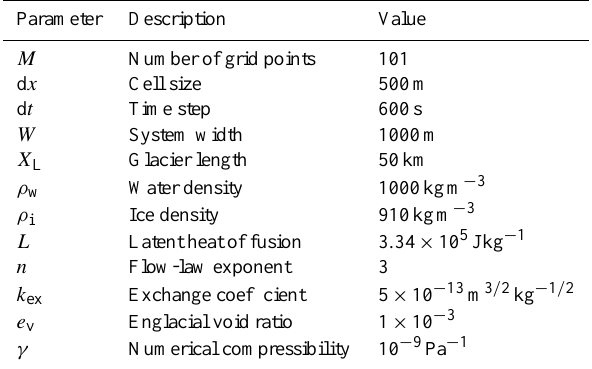
Table 1. Summary of hydrological model parameters (see Supple- ment for extended